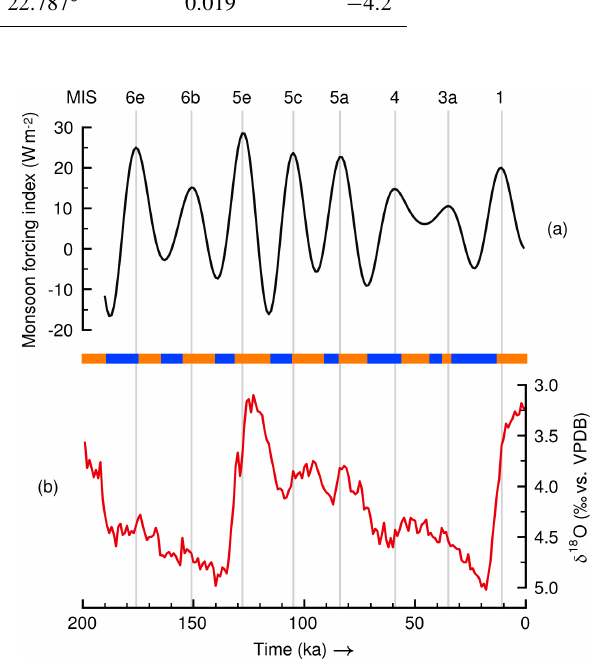
Figure A1. Notation for peaks of (a) monsoon forcing index using MIS labels on top, following the scheme in Railsback et al. (2015), who used the (b) Lisiecki and Raymo (2005) marine isotope stack data to label the time slices shown in a bar with different colours. The isotope data are with respect to the standard Vienna Peedee Belemnite (VPDB). Vertical lines indicate the monsoon forcing in- dex